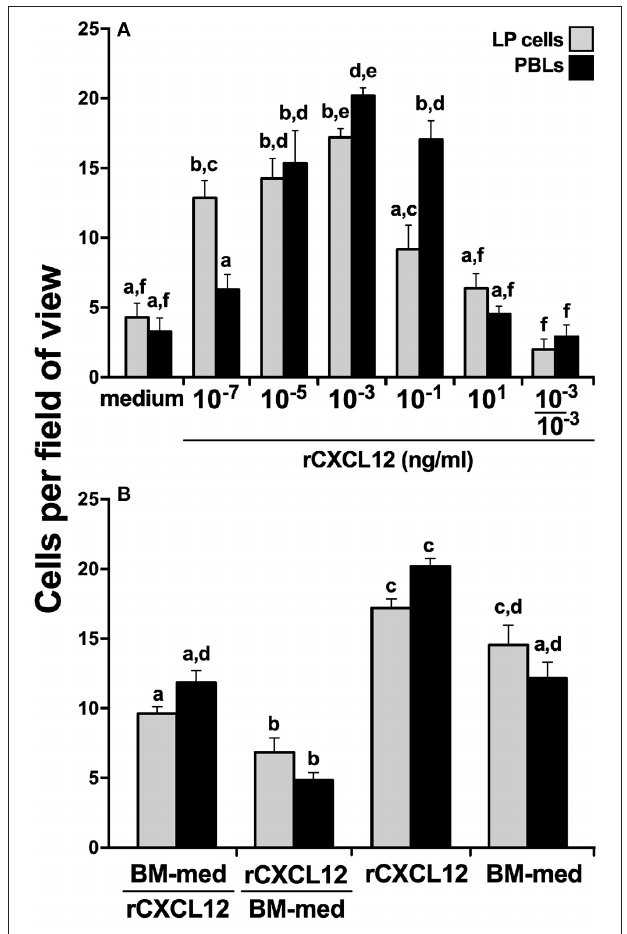
FIGURE 5 | X. laevis rCXCL12 is chemotactic to liver periphery and peripheral blood leucocytes. A recombinant X. laevis CXCL12 (rCXCL12, 10 − 7 -10 1 ng/ml) was examined for its capacity to chemoattract (A) liver periphery (LP) cells or peripheral blood leucocytes (PBLs; 10 4 cells/well) with chemokinesis assessed by adding 10 − 3 ng/ml of rCXCL12 (optimal dose) to both the upper and the lower chemotaxis chambers. (B) The relative capacities of tenfold concentrated bone marrow conditioned medium (BM-med) and rCXCL12 (10 − 3 ng/ml) to chemoattract LP cells and PBLs (10 4 cells/well) were compared through chemokinesis experiments by adding either BM-med or rCXCL12 and rCXCL12 or BM-med to the upper and lower chemotaxis chambers, respectively (denoted as BM-med/rCXCL12; rCXCL12/BM-med) and compared to BM-med or rCXCL12 in only bottom wells. All chemotaxis/chemokinesis experiments were performed using cells from 5 individual animals ( N = 5), enumerating 10 random fields of view